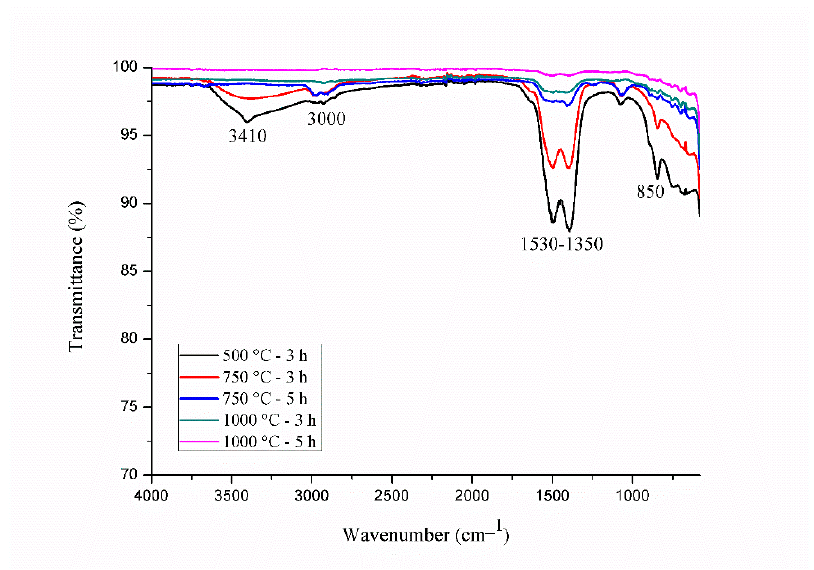
Figure 2. IR spectra of Gd 2 O 3 :Eu 3+ nanoparticles calcined at different temperatures and times.